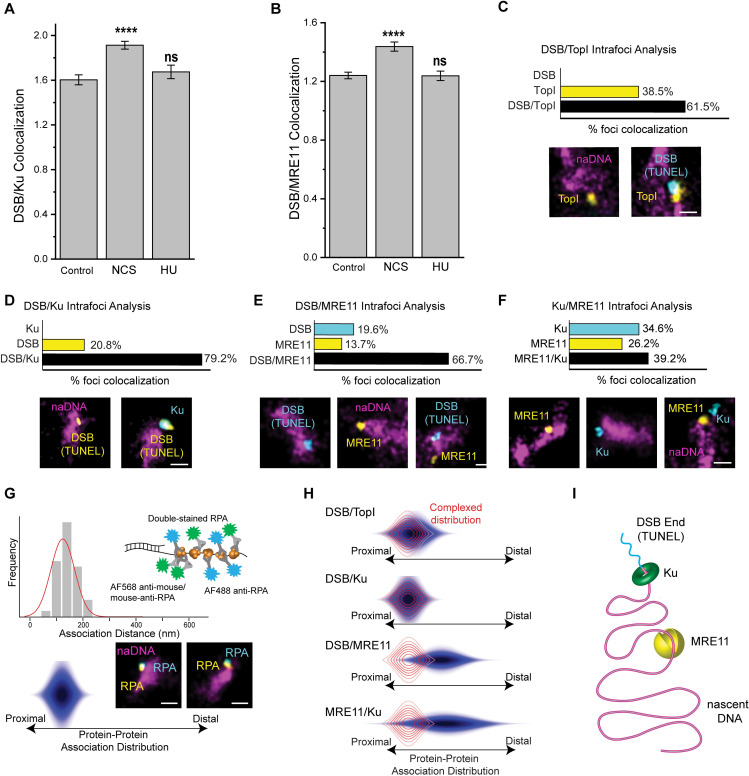
Ku and MRE11 colocalize to seDSB repair foci in a distally separated arrangement with Ku associating with the DSB end and MRE11 with nearby naDNA.(A) Quantification of colocalization of DSBs (via TUNEL labelling) with Ku in control cells and in cells immediately following treatment with CPT, NCS or HU. Representative whole-cell images shown in S8A–S8C Fig. (B) Quantification of colocalization of DSBs (via TUNEL labelling) with MRE11 in control cells and in cells immediately following treatment with CPT, NCS or HU. Representative whole-cell images shown in S8D–S8F Fig. (C) Three color analysis of TopI and DSB (using TUNEL labeling) localization at repair foci immediately following 1 hour of CPT damage. Representative whole-cell control and CPT-treated cells shown in S9A and S9B Fig. (D) Three color analysis of Ku and DSB (TUNEL) localization at repair foci immediately following 1 hour of CPT damage. Representative whole-cell control and CPT-treated cells shown in S9C and S9D Fig. (E) Three color analysis of MRE11 and DSB (TUNEL) localization at repair foci immediately following 1 hour of CPT damage. Representative whole-cell control and CPT-treated cells shown in S9E and S9F Fig. (F) Three color analysis of MRE11 and Ku localization at repair foci immediately following 1 hour of CPT damage. Representative whole-cell control and CPT-treated cells shown in S9G and S9H Fig. (G) A histogram (top) and resulting 3D color-contoured distribution (bottom) and accompanying model (right) showing quantification of the rendered distance between the centers of mass of the same super-resolved RPA foci immunolabeled indirectly with mouse-anti-RPA/Alexa-568-anti-mouse and directly with Alexa-488 conjugated rabbit anti-RPA. These distributions depict proteins closely associated within the foci because of RPA accumulation on ssDNA. (H) Color-contoured protein-protein association distribution maps of protein associations immediately following CPT damage. The red overlap distribution shows the RPA/RPA modelled proximal distribution. (I) A model depicting the association of Ku and MRE11 with a seDSB repair foci in which the TUNEL signal localizes to the break alongside KU while MRE11 localizes distally to double-stranded naDNA. Representative foci shown, scale bars represent 250 nm. Complete N values available in S1 and S2 Tables, number of replicates >3, number of cells imaged typically 20–60, number of individual foci manually scored typically 50–70.